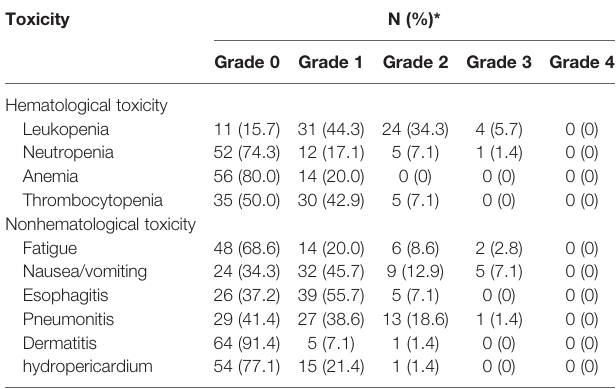
TABLE 4 | Acute Treatment